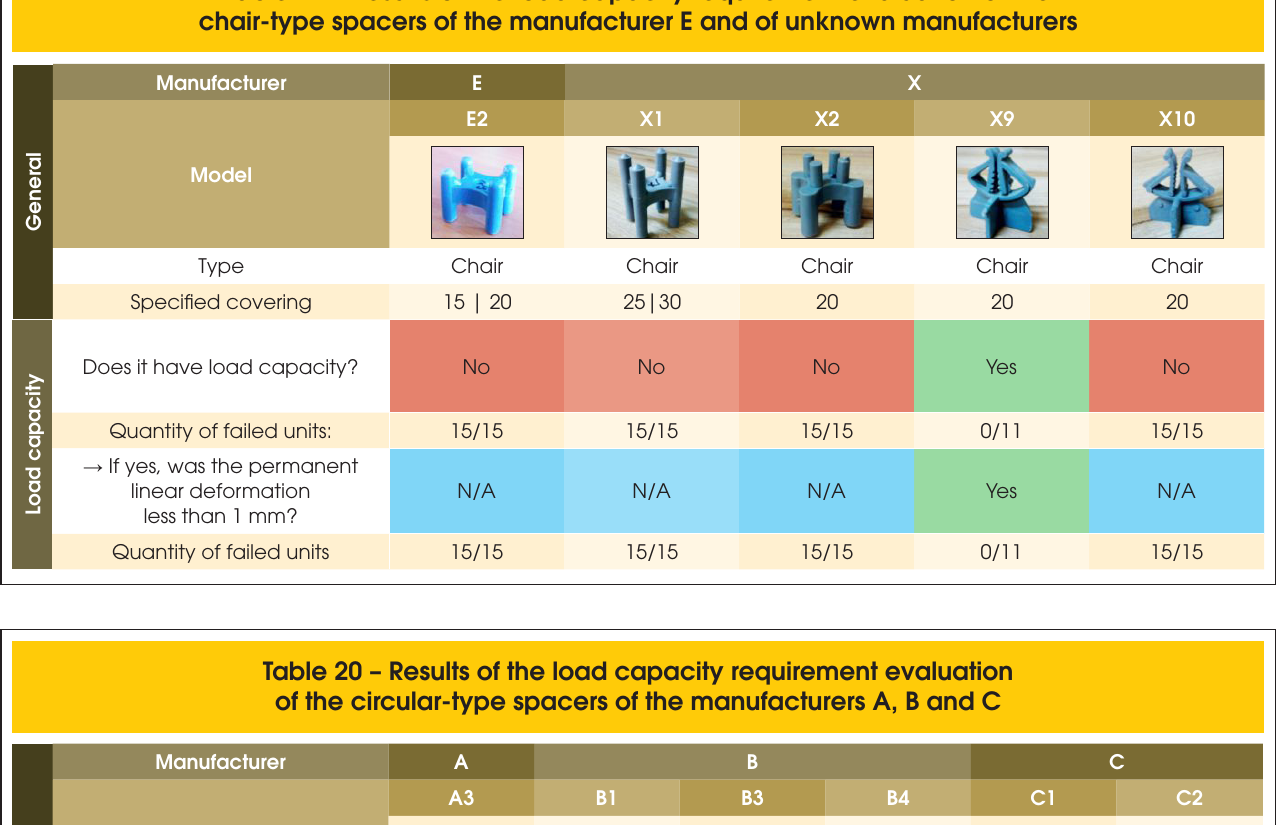
Table 19 – Results of the load capacity requirement evaluation of the